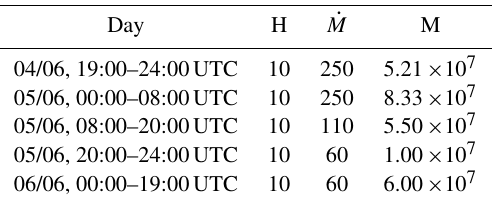
Table 8. H: column height (km); ˙ M : Mass flux (ktd − 1 ); M: emitted mass of SO 2